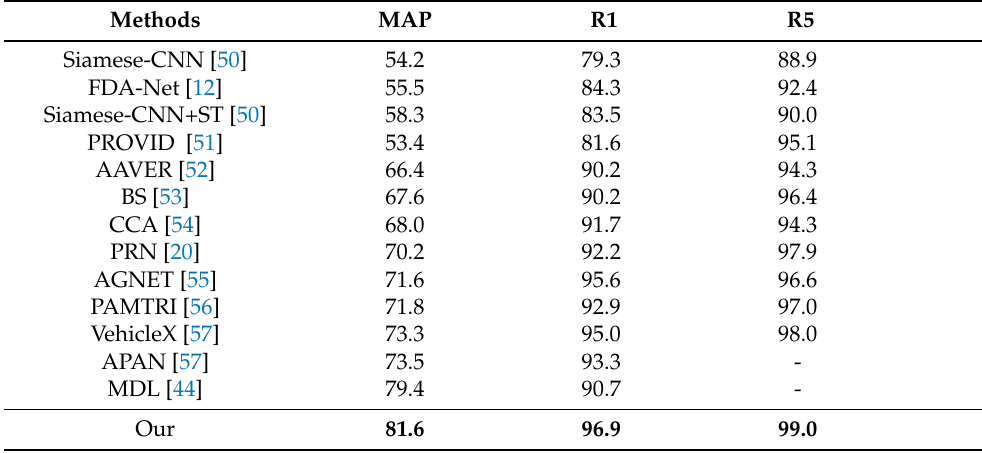
Table 3. Comparison with the Sota on VeRi-776 (%).